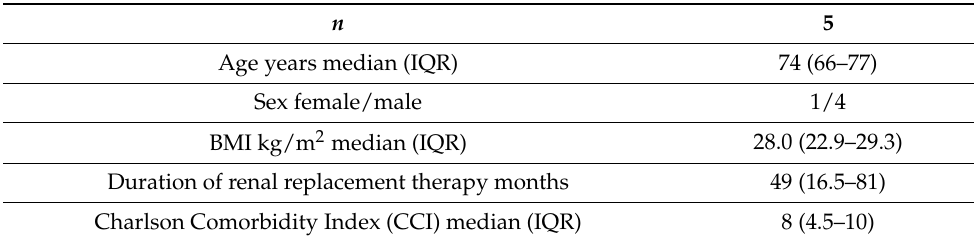
Table 4. Breakthrough SARS-CoV-2 cases among dialyzed study